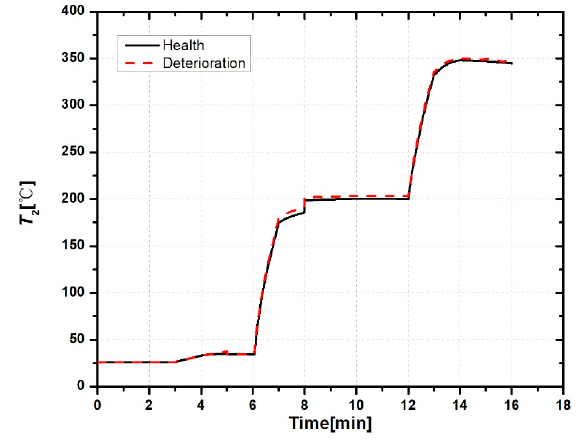
Figure 10. Simulation result of the compressor discharge temperature.